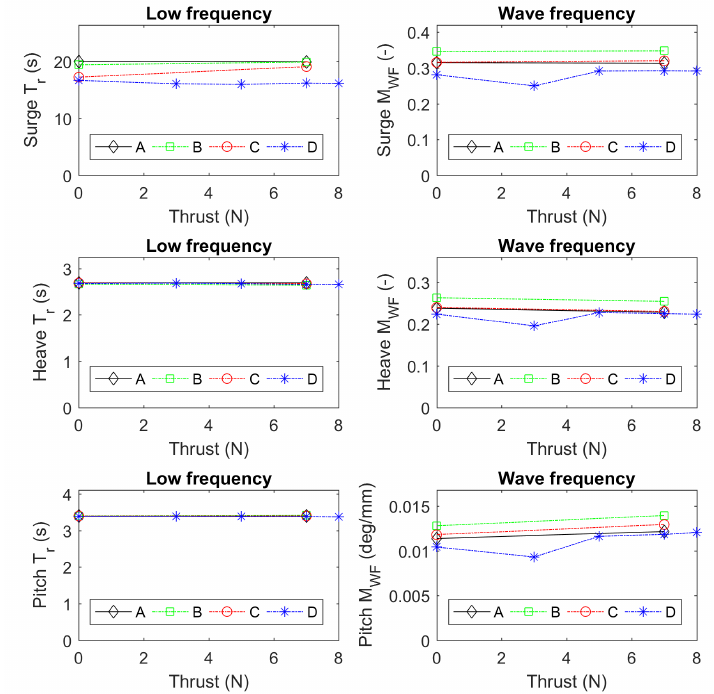
Figure 22. Metrics T r (left column) and M WF (right column) for JONSWAP T p = 1.29 s, H s = 7.5 cm per facility for surge (top row), heave (middle row), and pitch (bottom row) at thrust levels of 0, 3, 5, 7, and 8 N (8 N applied at facility D only).